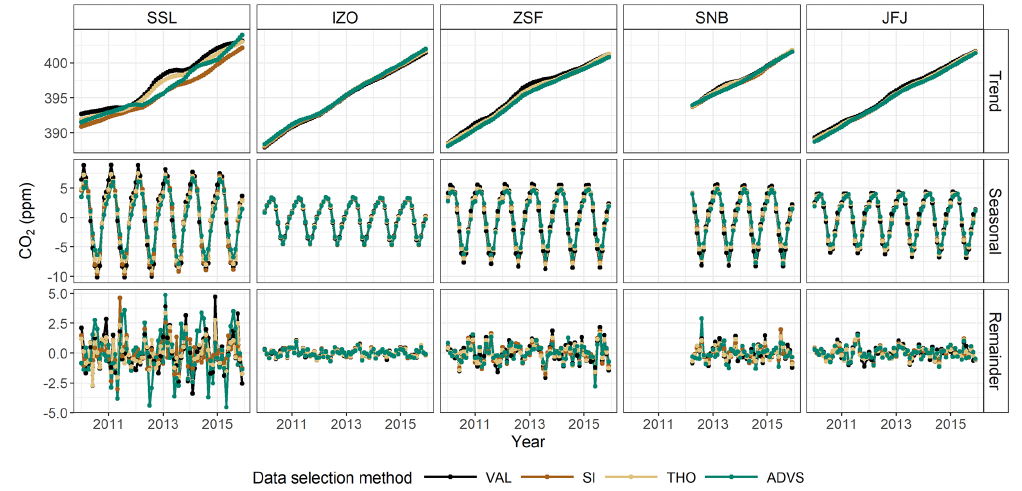
Figure 4. STL decomposition results from VAL (black), SI-selected (brown), THO-selected (yellow), and ADVS-selected (green) datasets at five GAW stations.